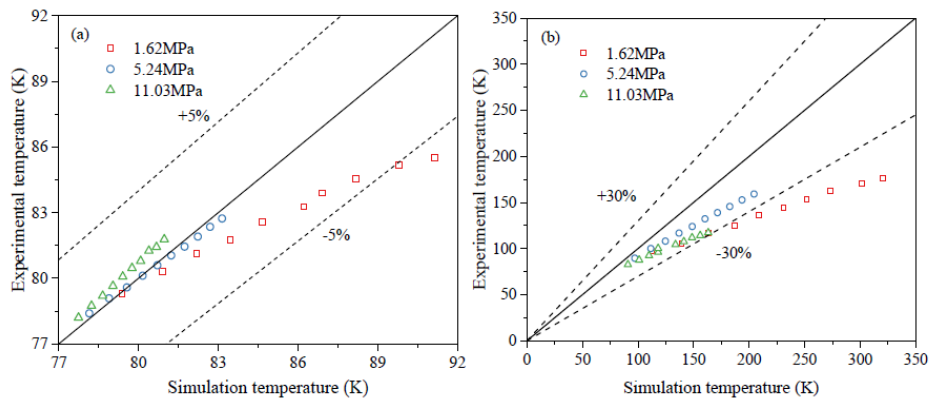
Figure 4. Comparison between the experimental and simulation temperature (( a ): T1, ( b ):